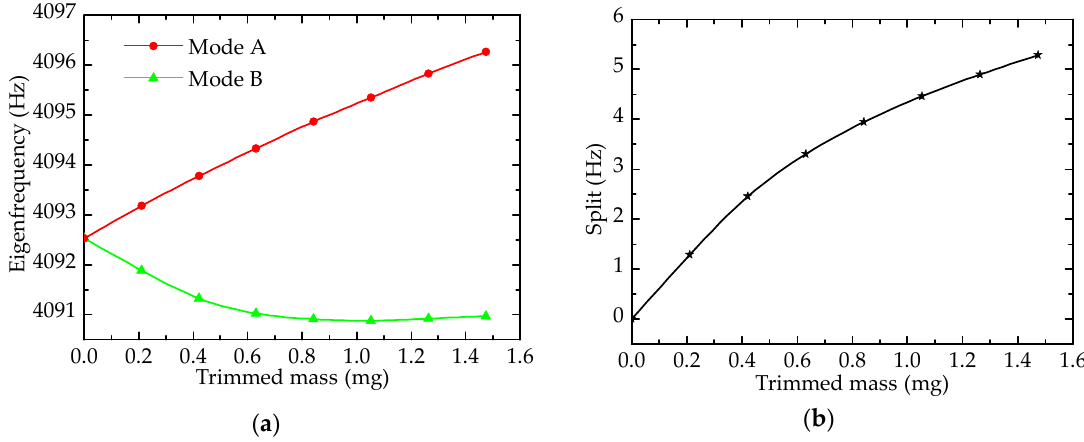
Figure 5. Effect of drilling holes on eigenfrequency: ( a ) Eigenfrequency; ( b ) Frequency split.